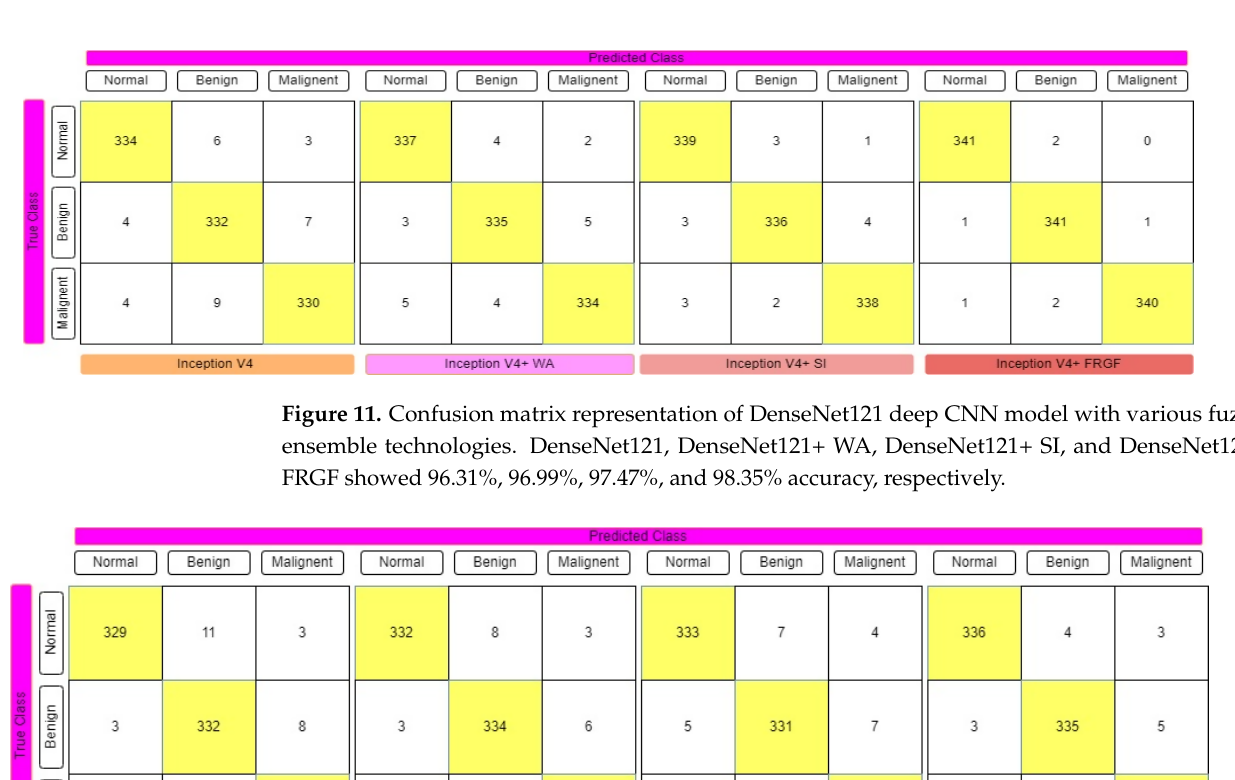
ble technologies. VGG-11, VGG-11+ WA, VGG-11+ SI, and VGG-11+ FRGF showed 96.21%, 96.70%,